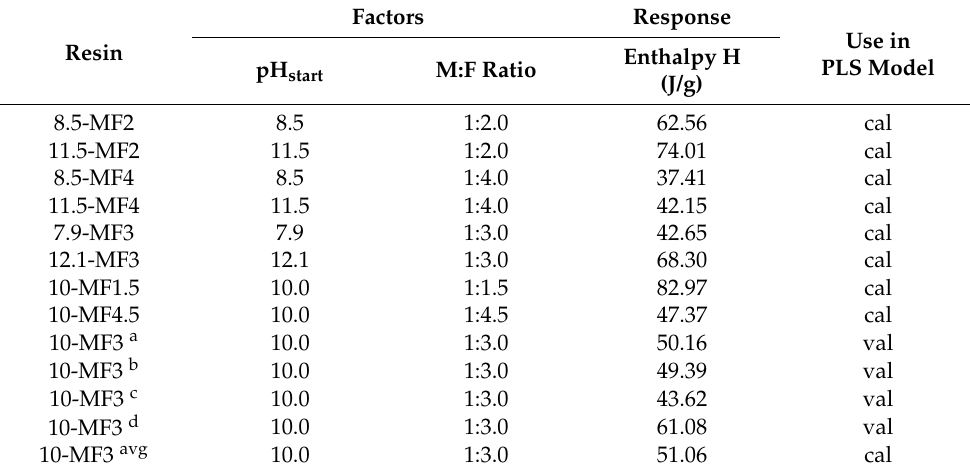
Table 1. Experimental design, response values for residual curing capacity (enthalpy H) with mean value of center point replicates and usage in model (cal, calibration; val, validation). Factors Response Factors Use in Resin Resin